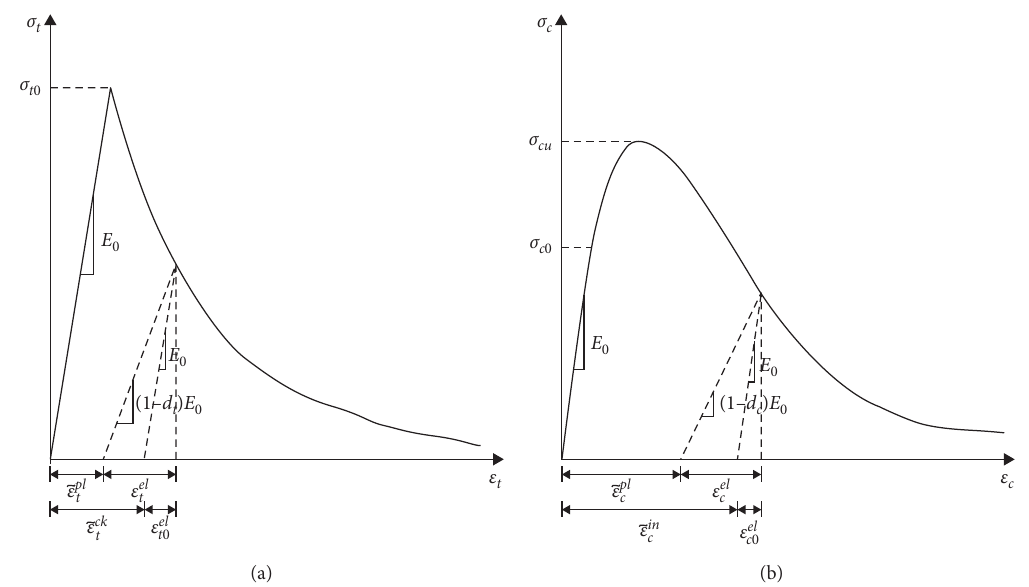
Figure 1: Schematic diagrams of concrete response under uniaxial tension and compression. (a) Tension. (b)